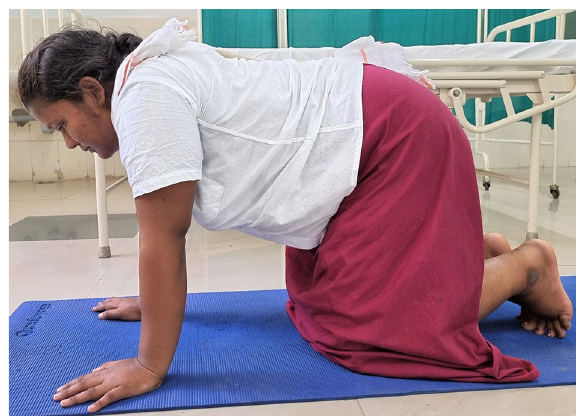
Figure 8. Marjariasana.